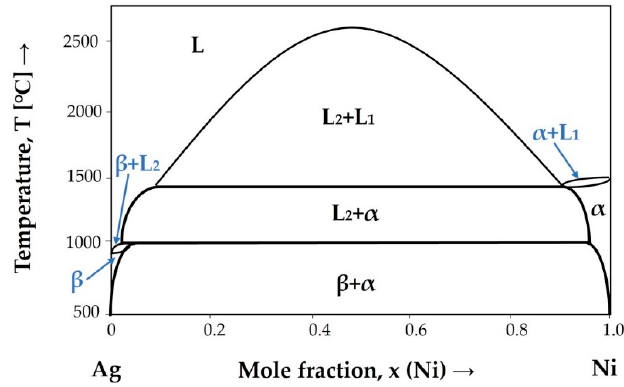
Figure 9. Phase diagram of a two—component Ag − Ni system [27].